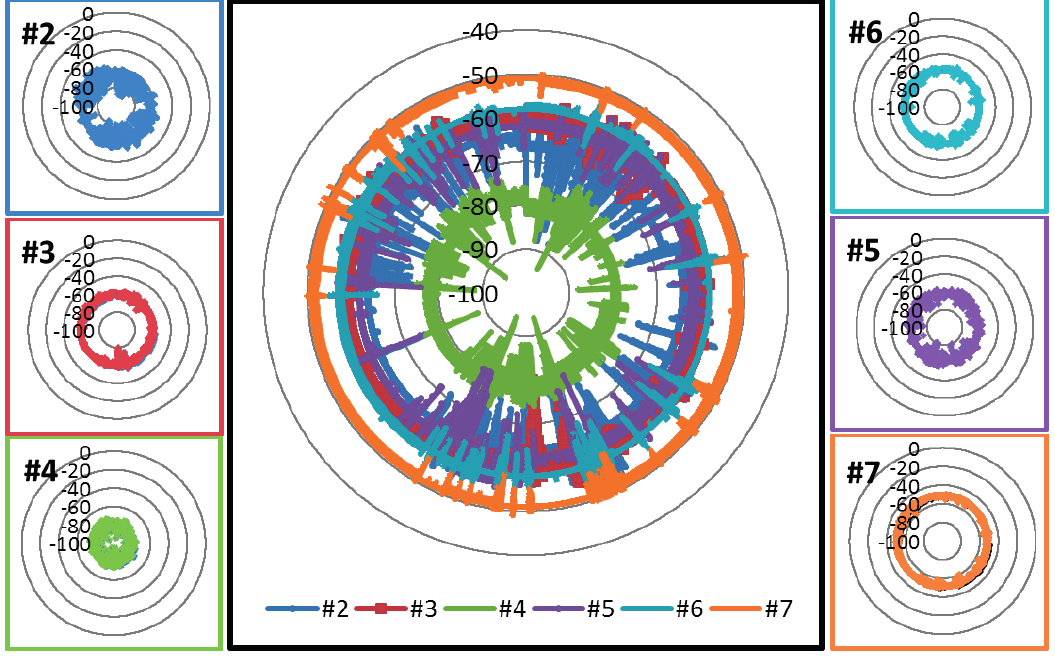
Figure 20. RSSI values (measured in dB) for each node.